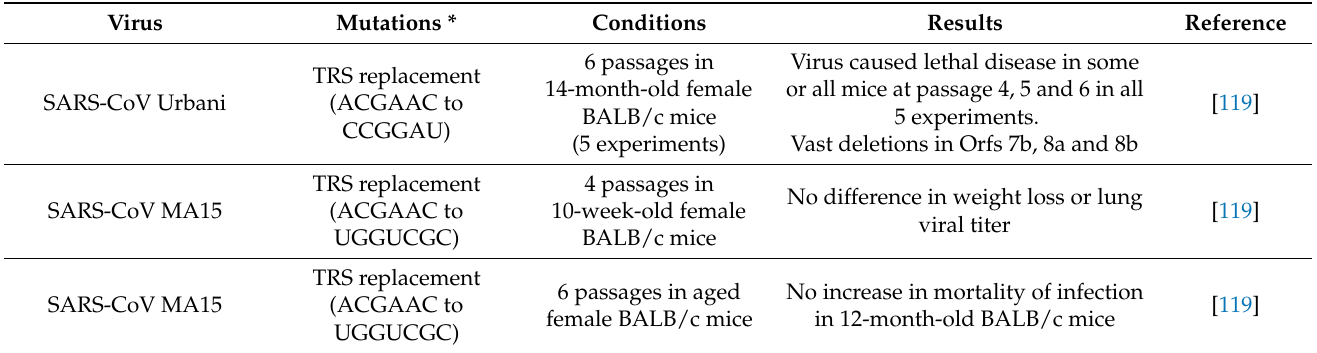
Table 3. A summary of the results of experiments that aimed to study the reversion to virulence of attenuated coronaviruses in